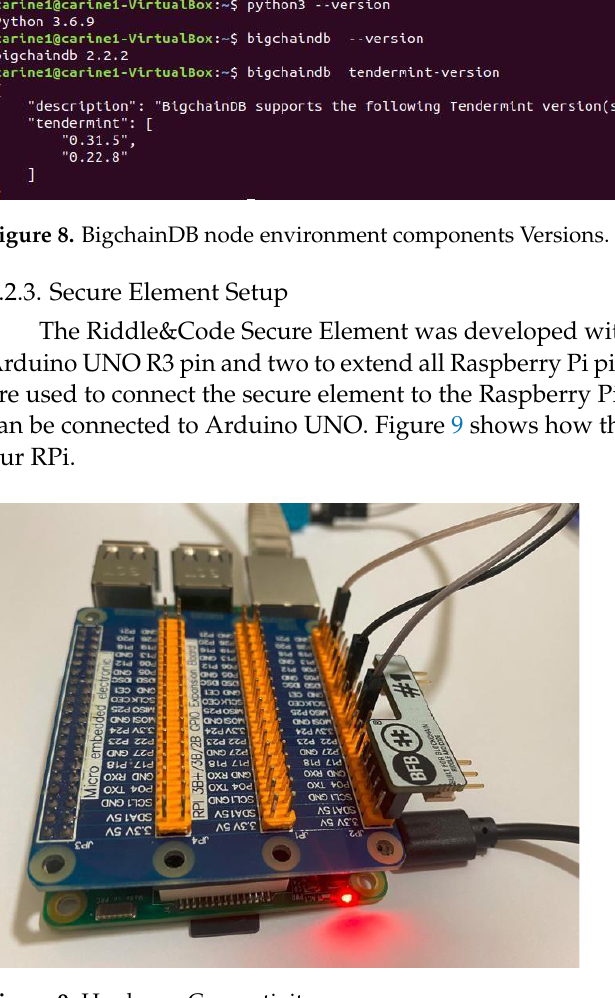
Figure 8. BigchainDB node environment components Versions.